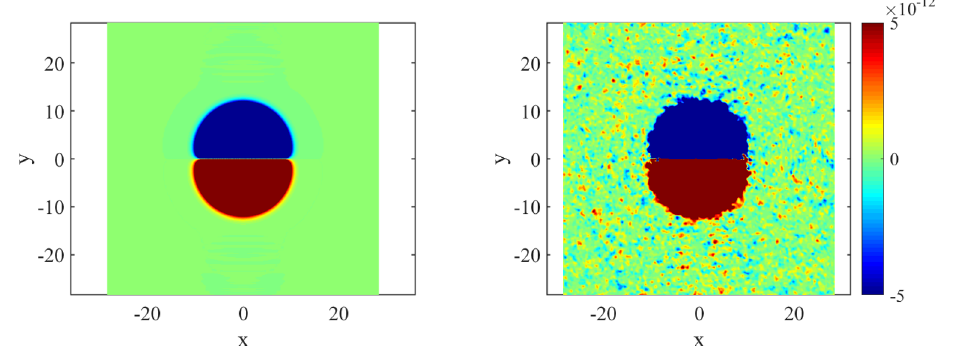
Figure 4 . Charge density at t = 2 × 10 7 with Higdon’s 2nd order absorbing boundary condition (left plot) and at t = 1 × 10 5 with the periodic boundary condition (right plot) in a 2+1D simulation. We see that with a periodic boundary condition the CSQ configuration becomes quite noisy after a moderate amount of